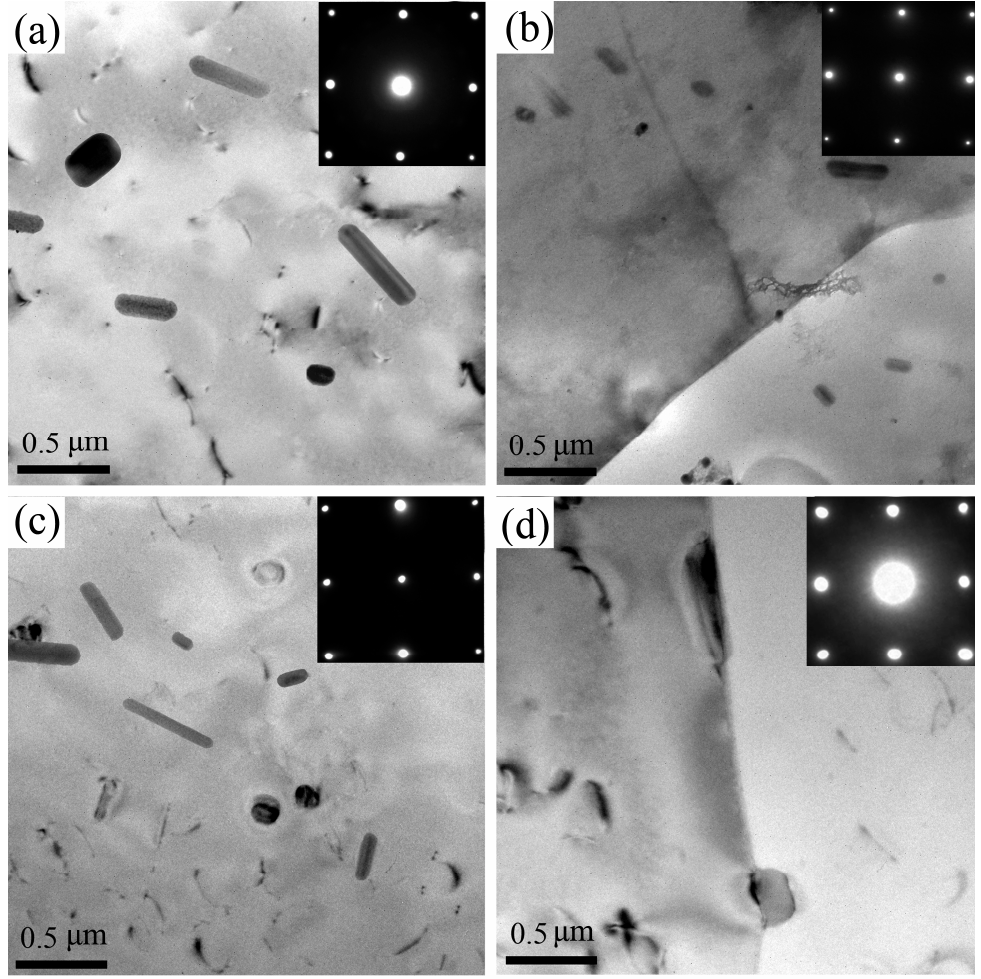
Figure 5. TEM bright field micrographs and corresponding SAED patterns (<100> α zone axis) of sample A ( a , b ) and sample B ( c , d ).